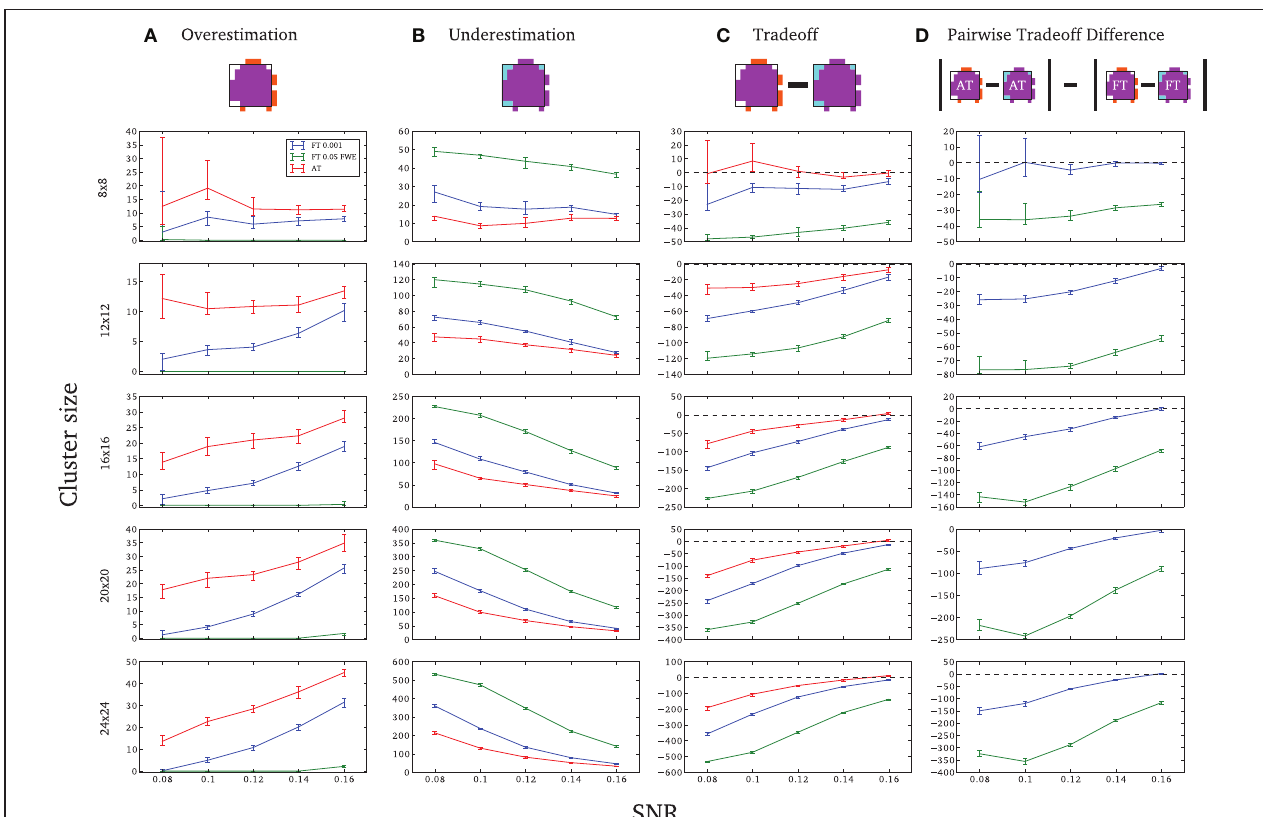
FIGURE 3 | Illustration of over and underestimation and performances of the different thresholding methods. At the top is an illustration of an observed cluster (purple) over the true underlying signal (square outline). Estimated voxels outside of the true border are in orange and missed voxels inside the border are in cyan. Below, graphs represent four biases. On the left are displayed the H-D estimates of the median cluster extent overestimation (A) , i.e., the number of false positive voxels for a particular cluster. Next are displayed the H-D estimates of the median cluster extent underestimation